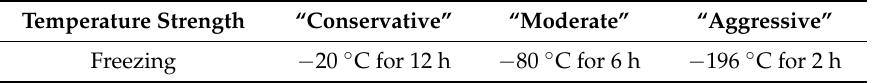
Table 3. The applied freezing stresses conditions for BCL-NS. Temperature Strength “Conservative” “Moderate”